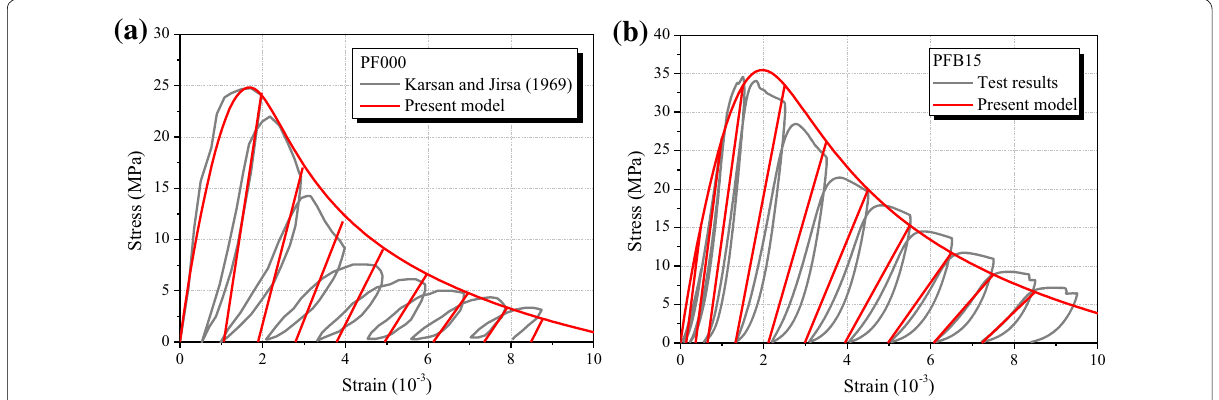
Fig. 20 Comparisons between experimental and present model results under cyclic loading. a Plain concrete; b PFB15.